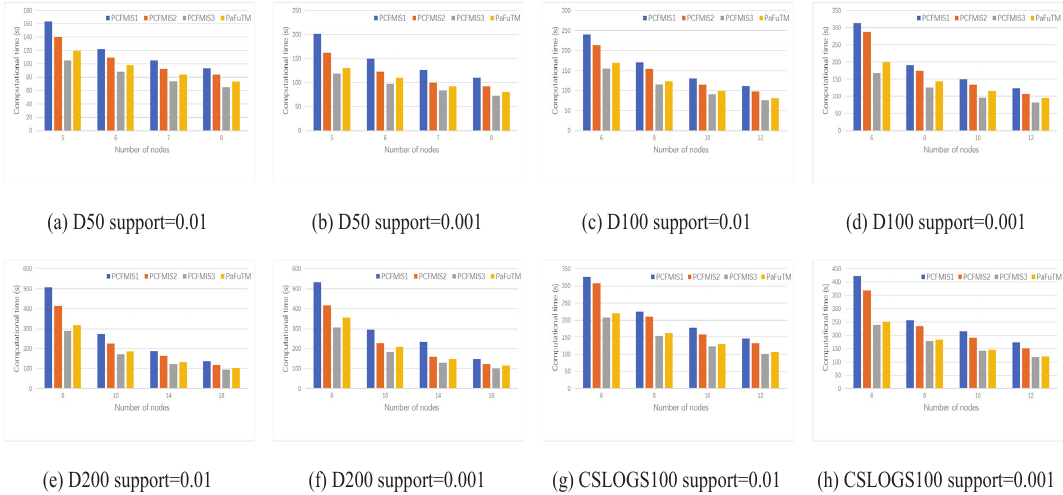
Figure 6. Computational time of four algorithms for four data sets on a large number of nodes.